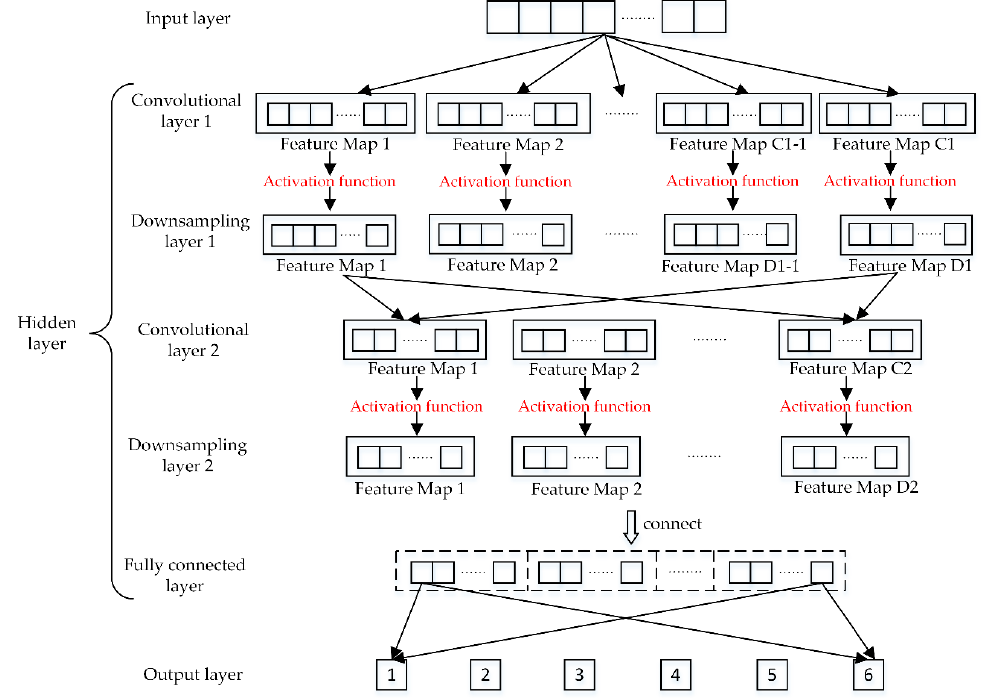
Figure 2. Structure of the CNN with two convolutional layers.